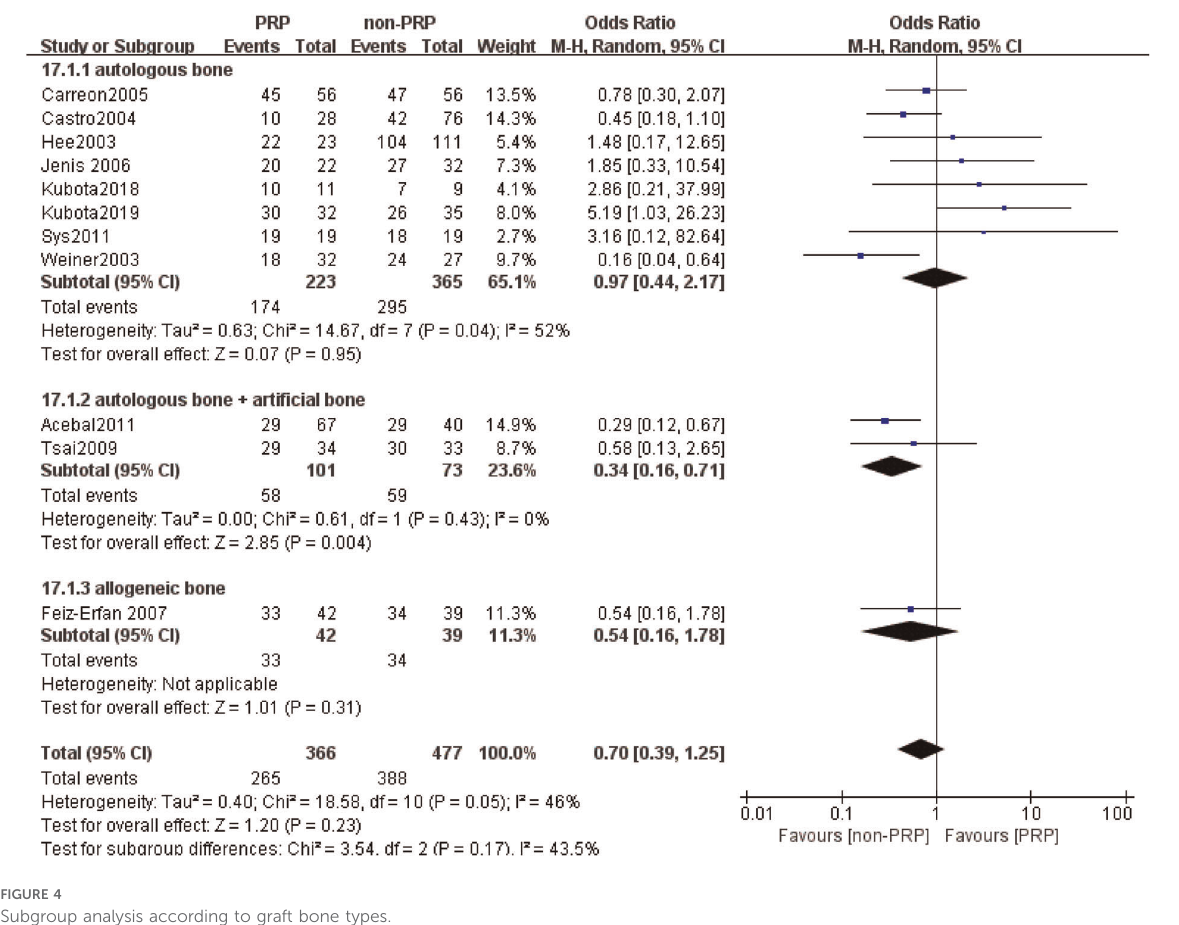
FIGURE 4 Subgroup analysis according to graft bone types.